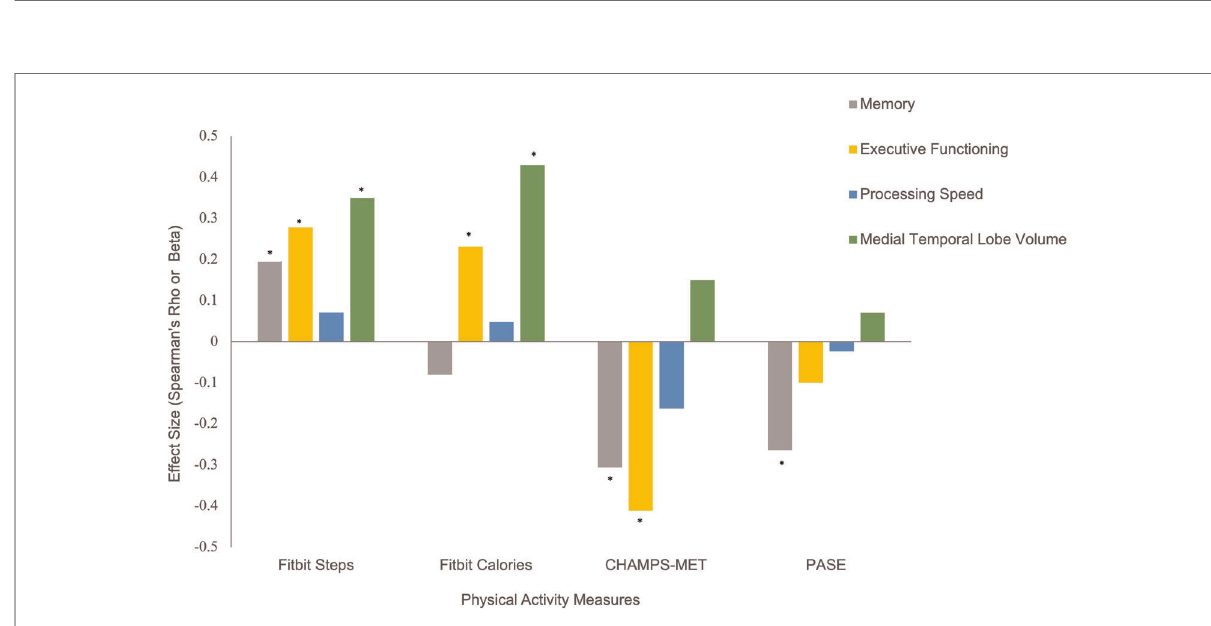
FIGURE 3 Physical activity measures with cognitive and brain MRI outcomes. Note. *Statistically signi fi cant at p